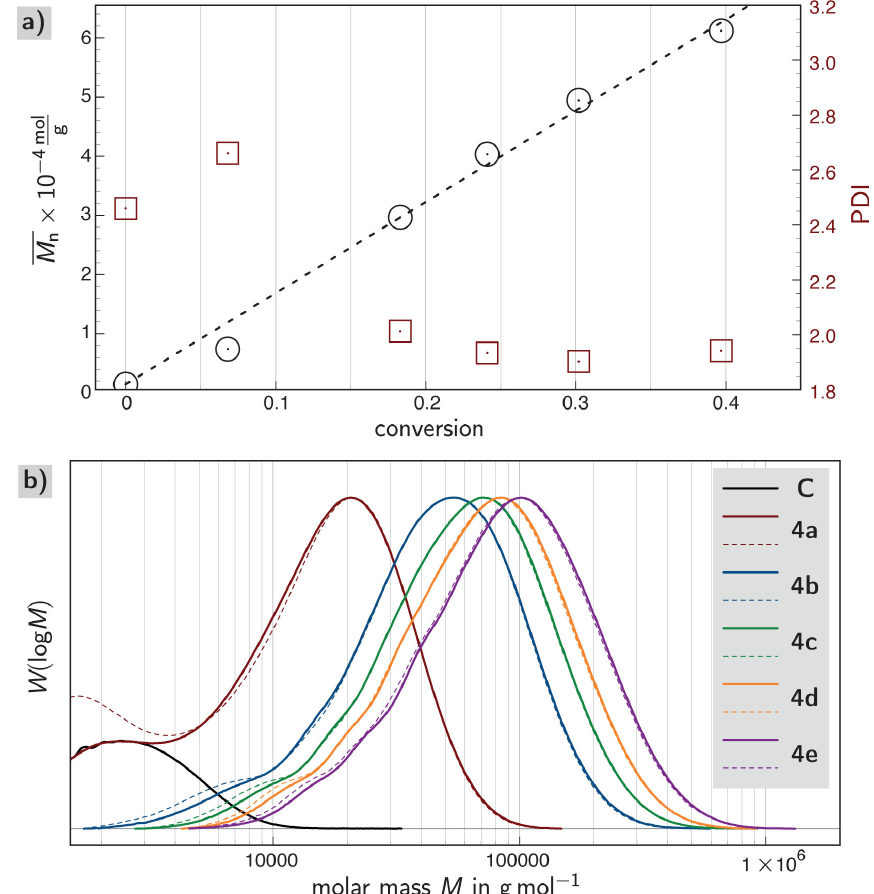
Figure 3. ( a ) M (black circles) and polydispersity index (PDI, red squares, RI signal) as n a function of monomer conversion for polymerization 4 ; dashed line: linear regression for M ; ( b ) Corresponding SEC curves (solid lines: RI signal, dashed lines: UV signal) and SEC n curve of the employed RAFT agent C